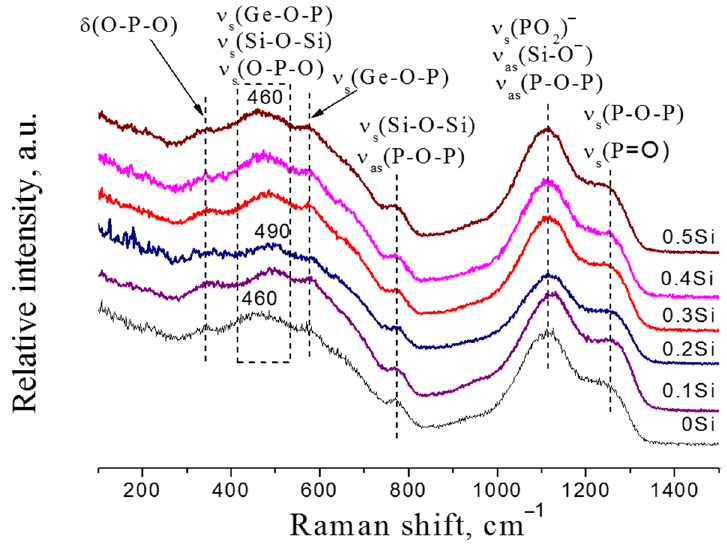
Figure 10. Raman spectra for 0Si–0.5Si glasses at room temperature.